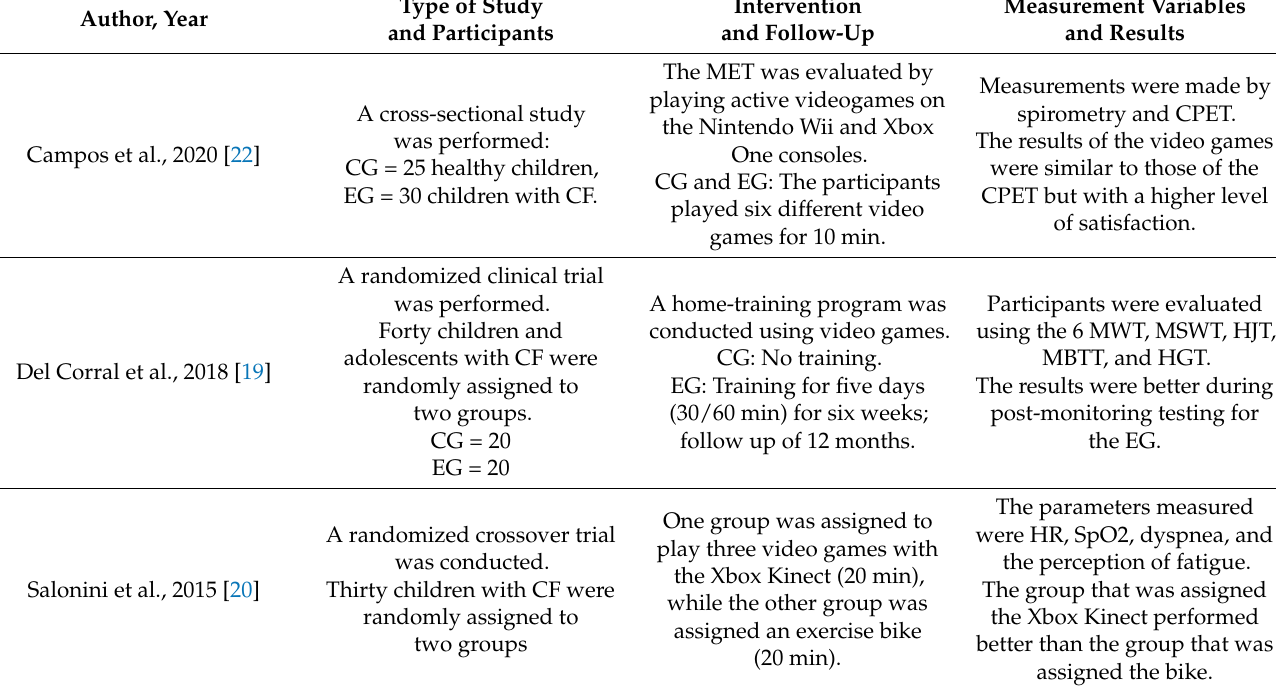
Table 2. The main characteristics of the selected